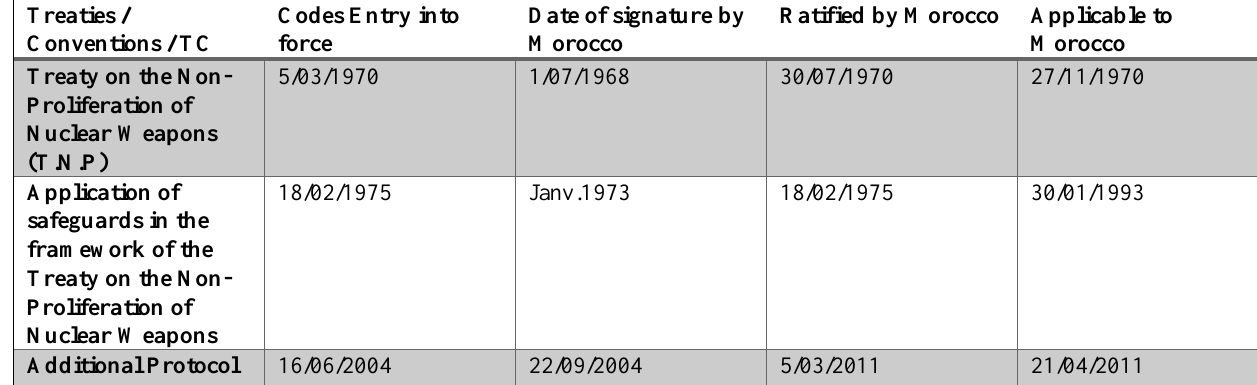
Table 1. Some Conventions and Treaties Ratified by